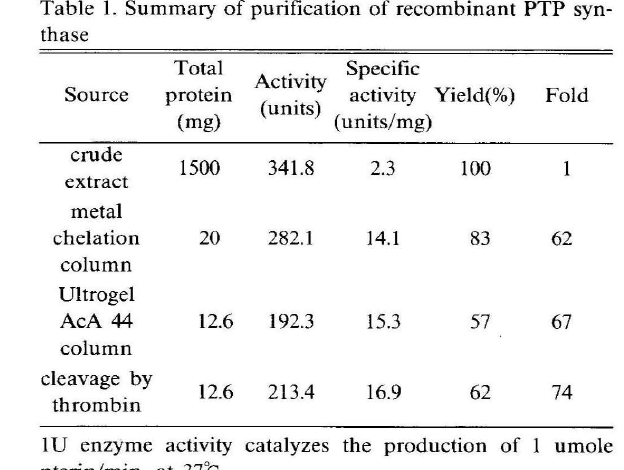
Figure 1. The sequences of cloning and expression region of pET-I5b vector and recombinant PTPS. After treatment of thrombin, the recombinant polypeptide has only 8 ad ditional amino acids. Table I. Summary of purification of recombinant PTP syn thase